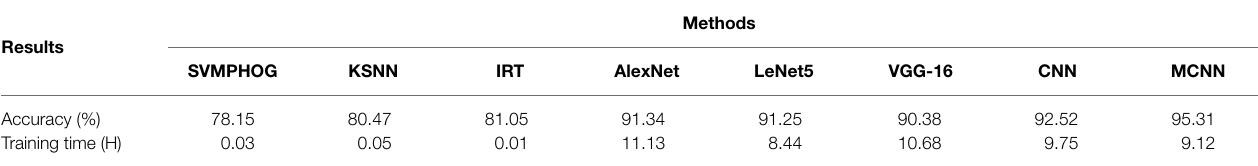
TABLE 3 | The average recognition accuracy and training time of apple disease on Kaggle dataset by seven methods.